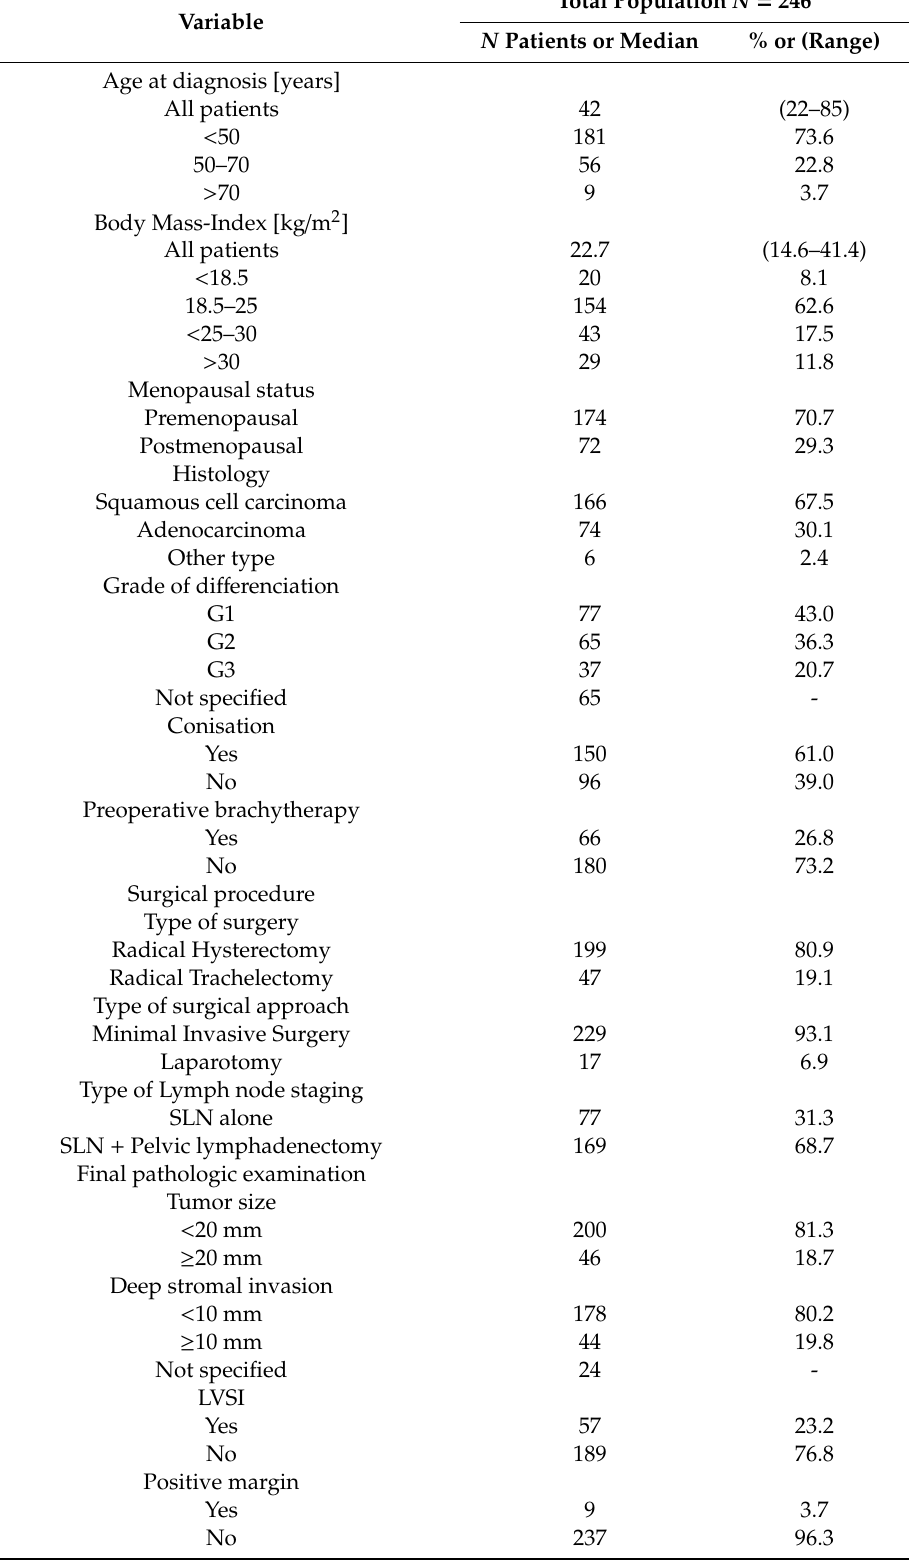
Table 1. Patient